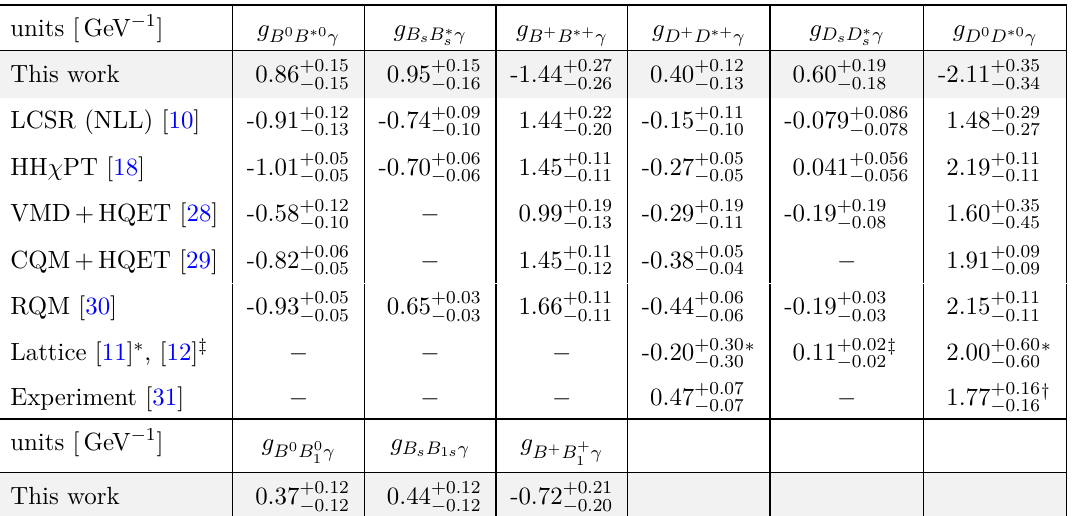
Table 7 . † The experimental value of g the width of the D ∗ 0 cf. the main text in section